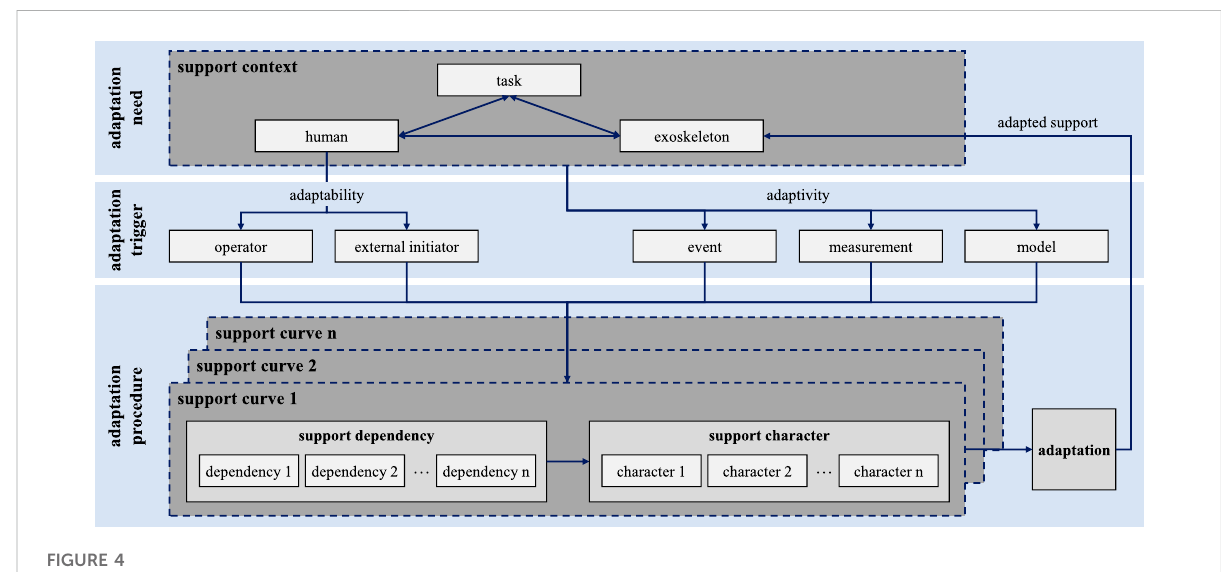
FIGURE 4 Framework for achieving adaptive system behavior of